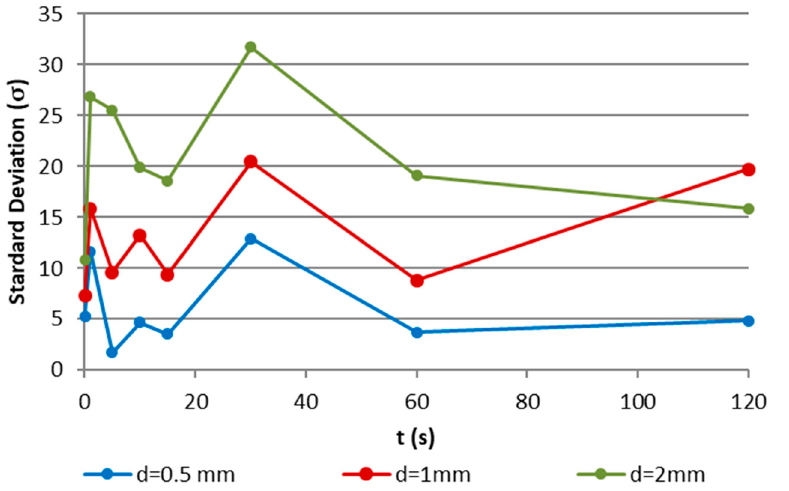
Figure 7. Standard deviation evolution of the thickness of the adhesion as a function of cutting time.